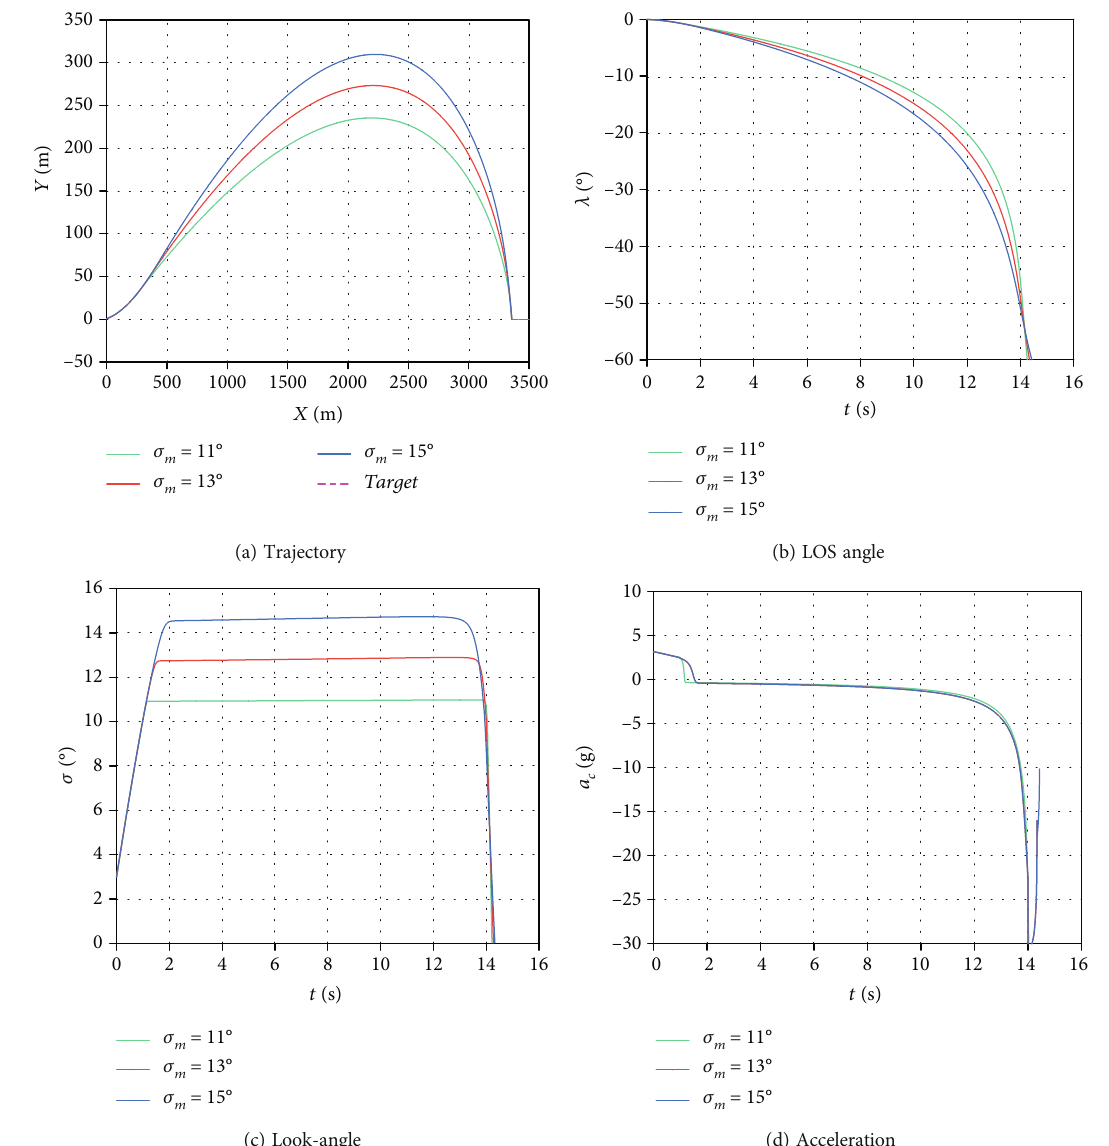
Figure 7: The results considering di ff erent FOV